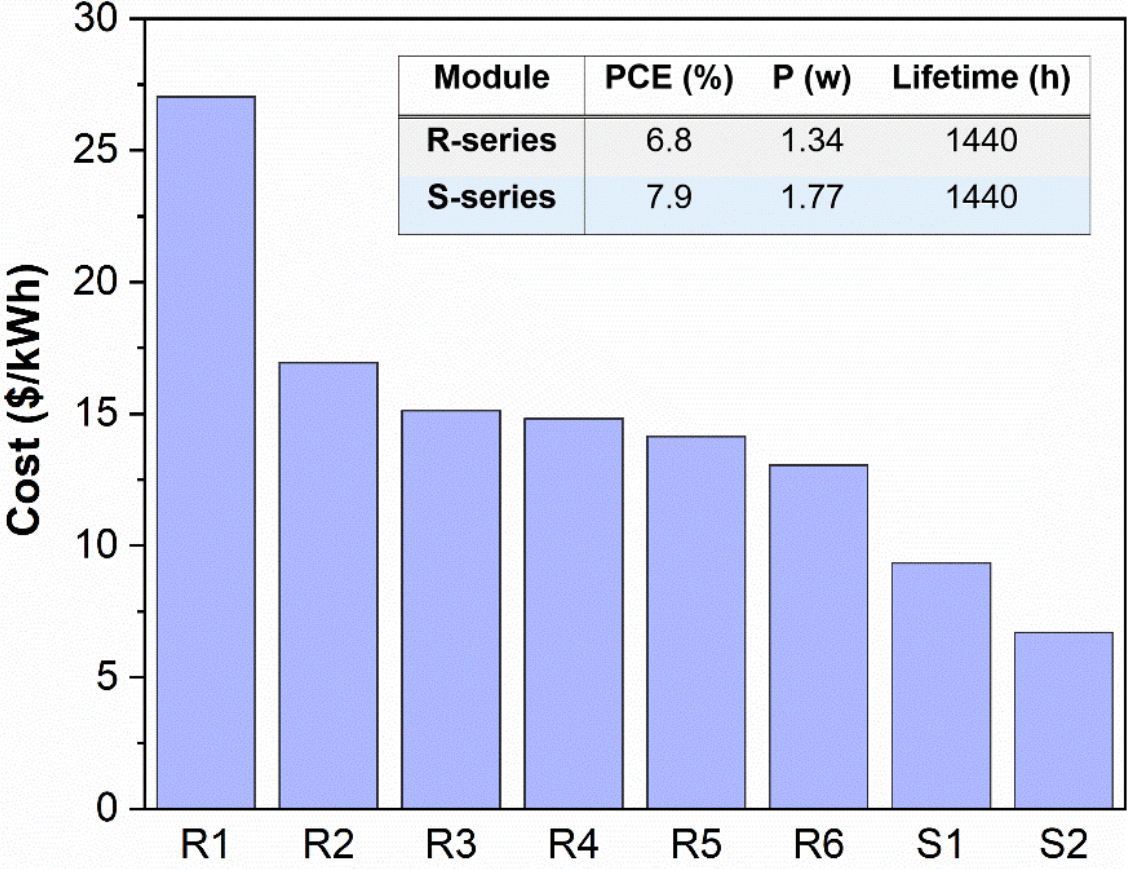
Figure 5. The cost per kWh for R- and S-series modules. Note: R2 and S1 module costs were calculated based on experimental data, and for the rest of the devices, the module costs were calculated based on the proposed manufacturing strategies. The $/kWh was obtained by dividing a module cost ($) by the module power (kW) and lifetime in hours.